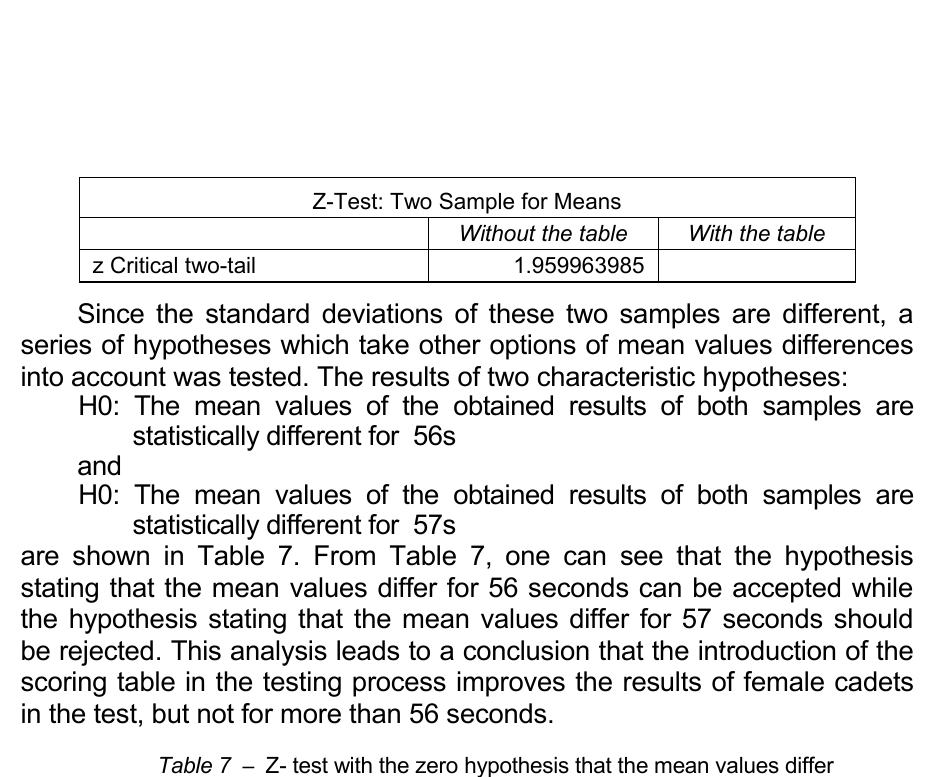
Table 7 – Z- test with the zero hypothesis that the mean values differ for 56 seconds (left) and 57 seconds